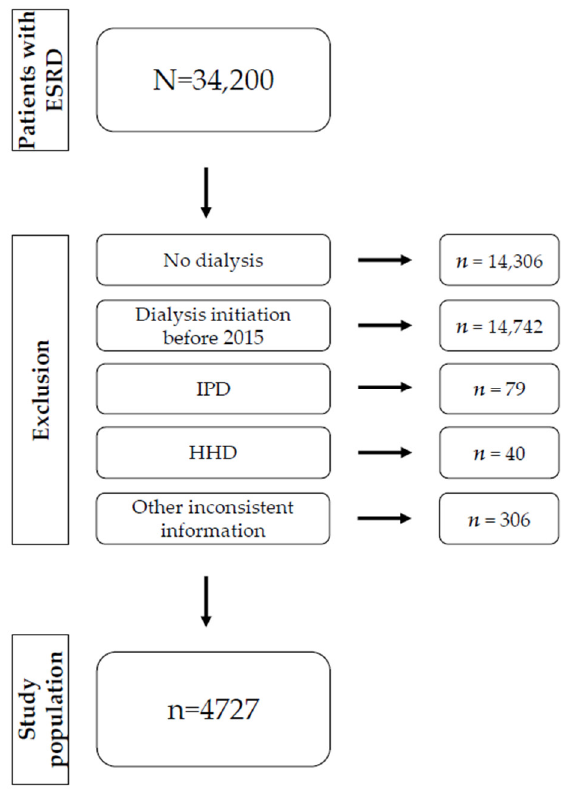
Figure 1. A flow chart about the exclusion of participants. Notes: Patients with ESRD of the SHIs had at least one documentation of the ICD code N18.5 between 2012 and 2016. ESRD patients who did not start a dialysis treatment, started dialysis before 2015, conducted IPD or HHD, or had any inconsistent information were excluded (see method section). Table 1. Characteristics of HD and PD patients.